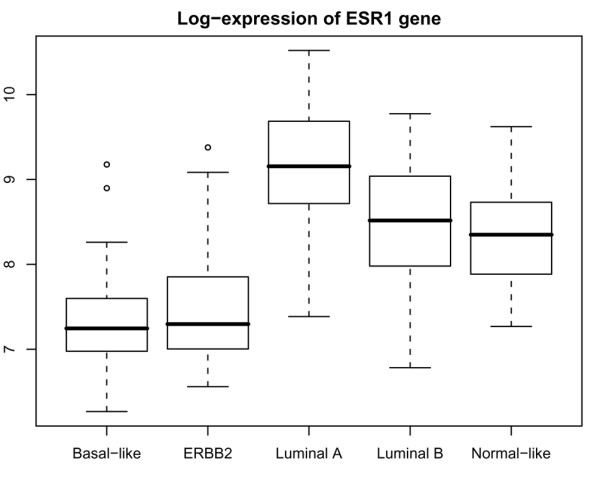
Logarithmic expression of the ESR1 gene. Boxplots are shown of ESR1 gene expression values (log2 transformed) against subtype in both Swedish cohorts.